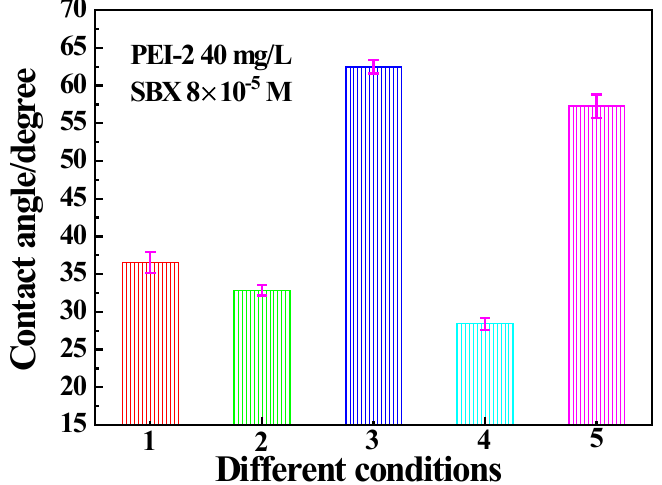
Figure 7. Contact angle measurement results under different conditions (1—natural; 2—treated with aqueous solution at pH 7.5; 3—treated with 8 × 10 − 5 M SBX at pH 7.5; 4—treated with 40 mg/L PEI-2 at pH 7.5; 5—treated with 40 mg/L PEI-2 then 8 × 10 − 5 M SBX, at pH 7.5).